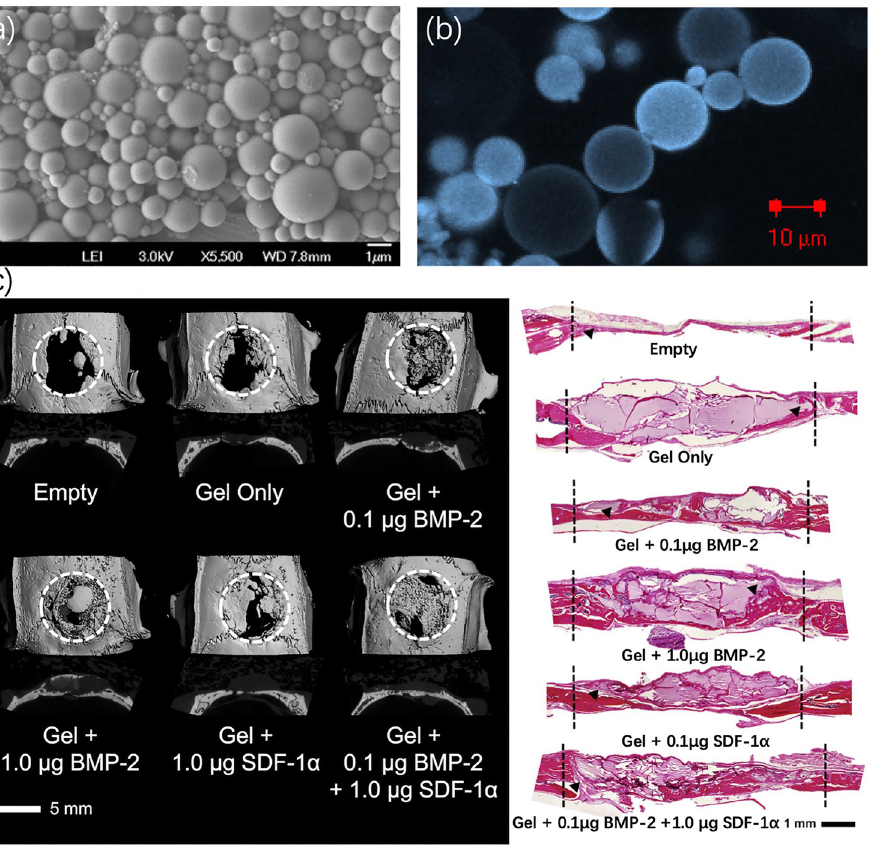
Figure 10: ( a ) The SEM of heparin - decorated, HA - based HGPs [ 135 ] . ( b ) The Cascade blue staining of BMP - 2 - loaded HGPs by HA [ 136 ] . ( c ) The μ CT reconstructions and hematoxylin and eosin staining of calvarial defects for all treatment groups at 6 weeks [ 140 ]